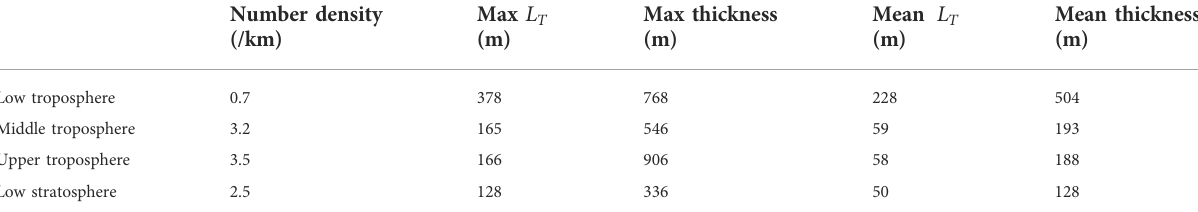
TABLE 2 Turbulence number density, maximum Thorpe scale and other characteristics of the 4 turbulence